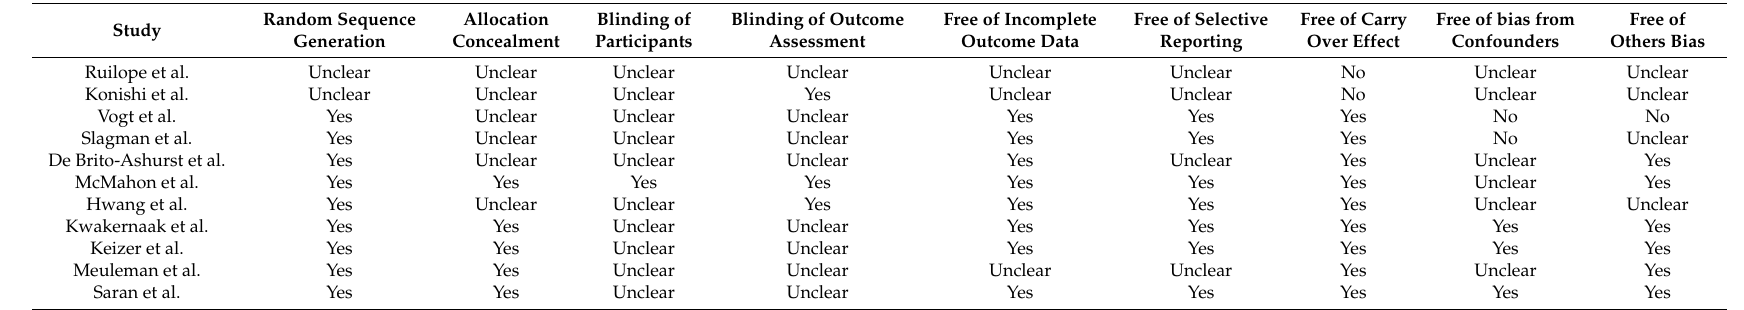
Table 3. Risk of bias in studies included in the